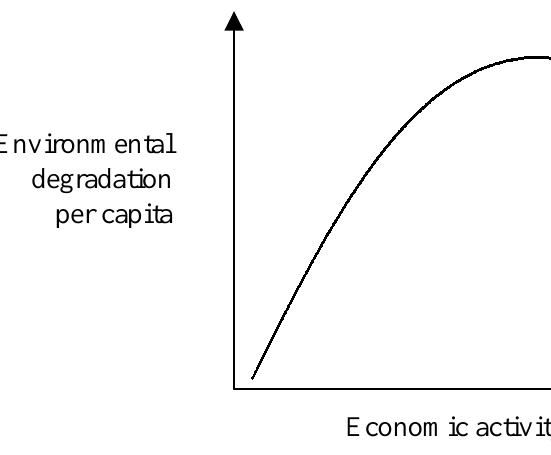
Figure 1. The Environmental Kuznets Curve (EKC) Looking at European data, it does not appear that transport demand or transport energy consumption fit the EKC hypothesis either. In recent decades, GDP has increased in all EU countries, and transport demand and transport energy consumption have both continued to increase. It is clear that decoupling transport demand and transport energy from economic growth (as in the case of carbon dioxide emissions) will not occur by simply allowing the economy to grow. A number of other factors that might play an important role in decoupling are identified by IBRD (1992) and include: (a) the types of goods and services produced; (b) the efficiency of the use of inputs (raw materials); (c) the ability to substitute for scarce resources; and (d) the ability to use clean technologies and implement clean management